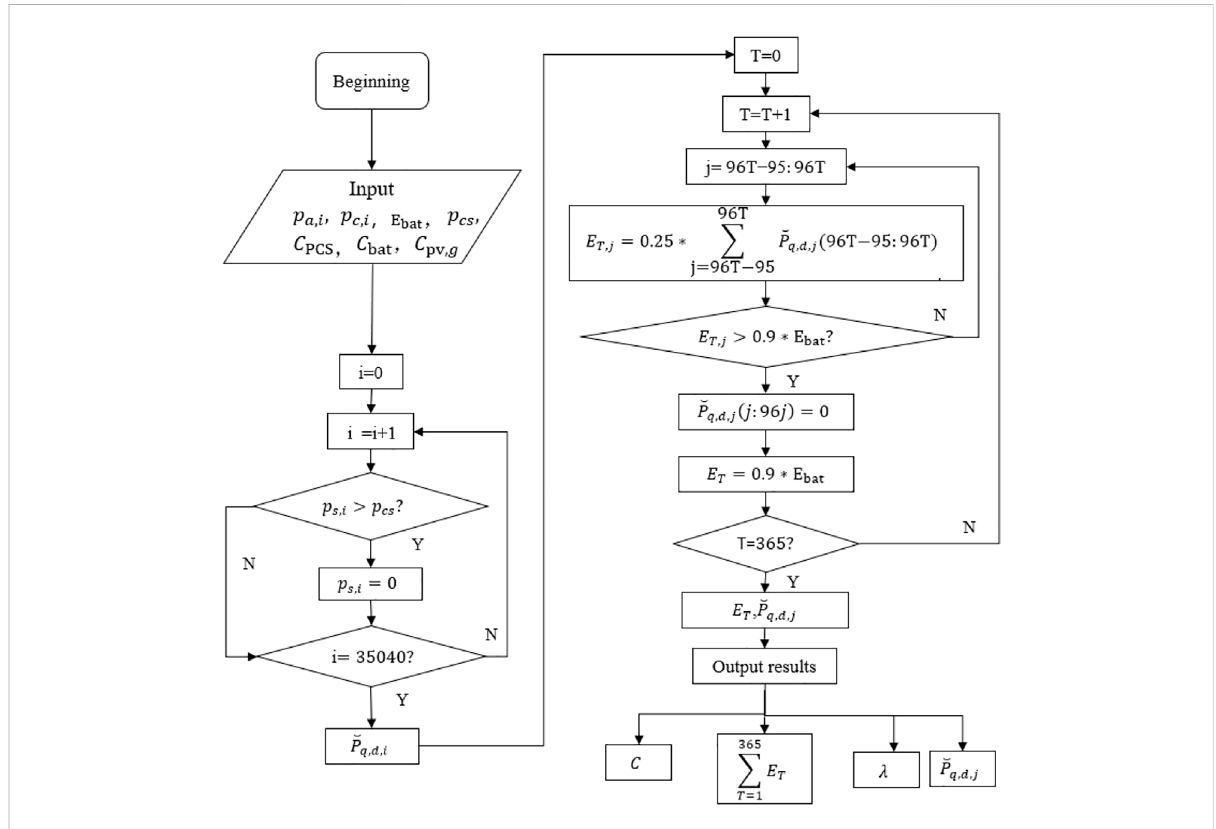
FIGURE 2 Implementation process of energy storage capacity size